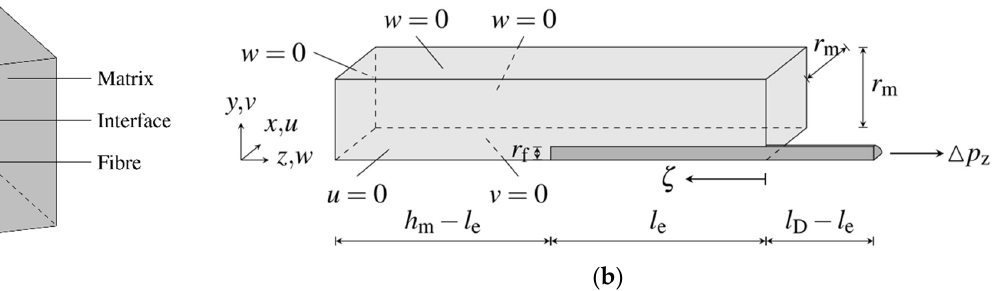
Figure 7. Geometric model of fibre-matrix composite (adapted from [27]): ( a ) General scheme and ( b ) Finite-element-model for simulation of a pullout test with geometry parameters and boundary conditions.